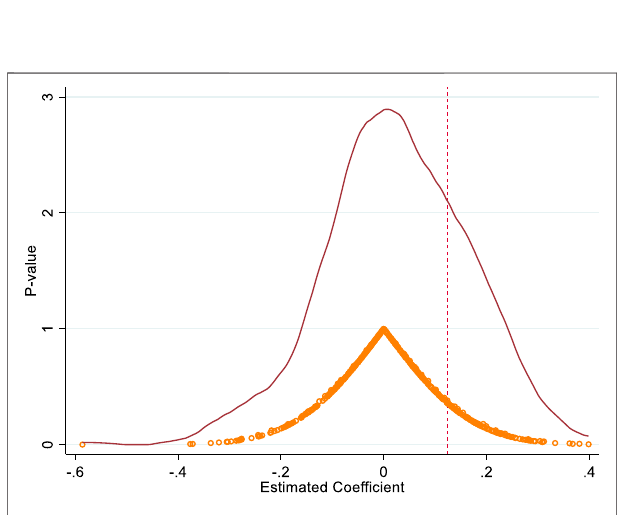
FIGURE 2 | Placebo test result.